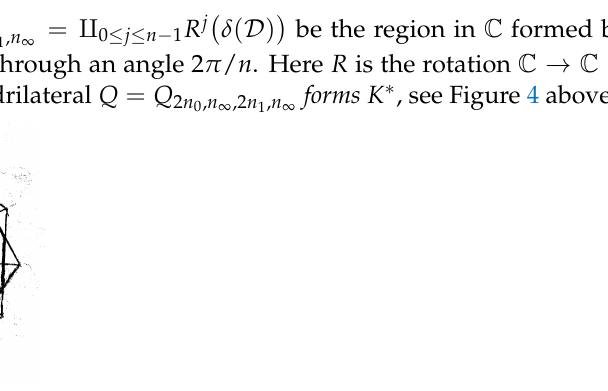
formed by 4,4,4